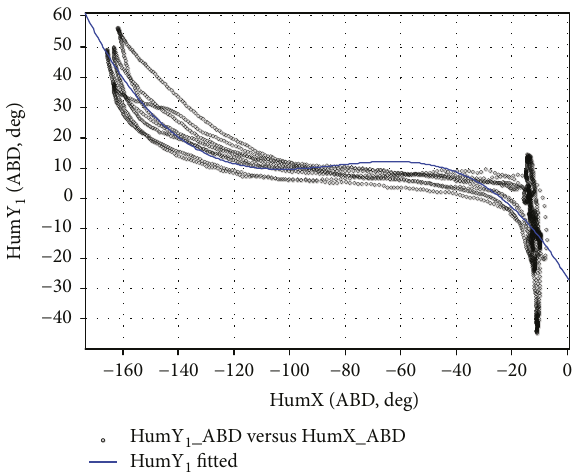
Figure 18: The relation between plane of elevation angle and elevation angle